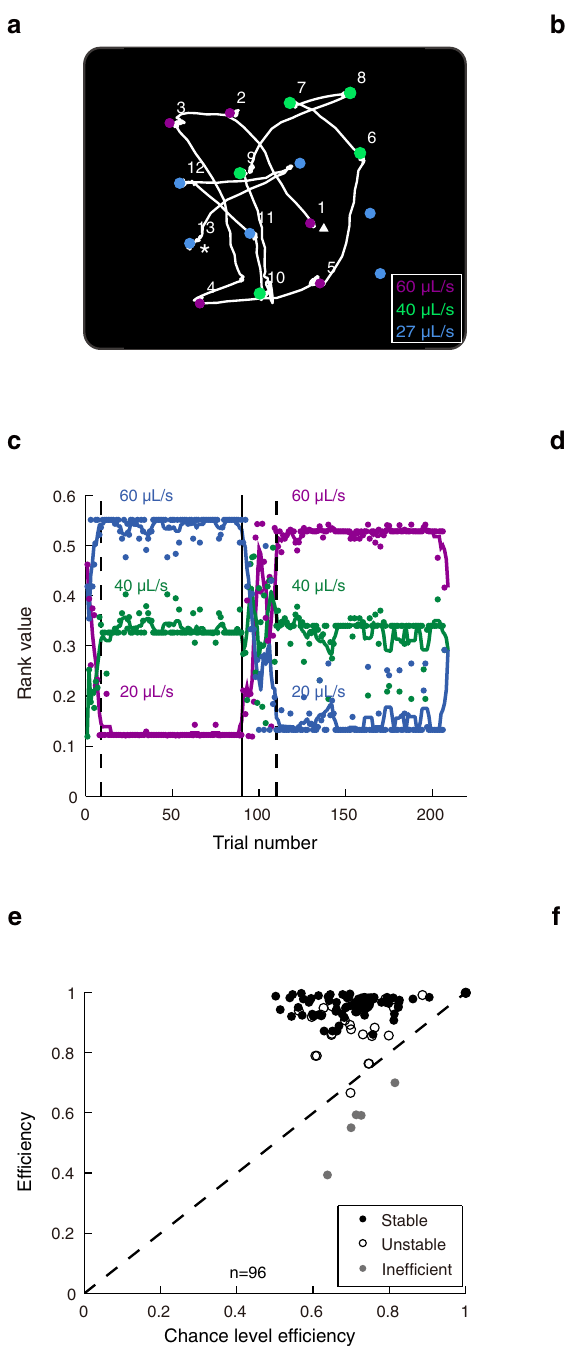
Supplementary Fig. 4c, d for individual monkey data). This pattern of reaction times was consistent with a neural signal that starts from a common value-threshold level that ramp up to a fi xed saccade threshold. Conversely, if the RF target was not selected for the subsequent saccade, SC activity remained strongly correlated with its value (Fig. 5a — dashed lines; Fig. 5d; n-way ANOVA test, effect of value, F 3,449 = 174.93, P = 4.1 × 10 − 75 ; see Supplementary Fig. 4e, f for individual monkey